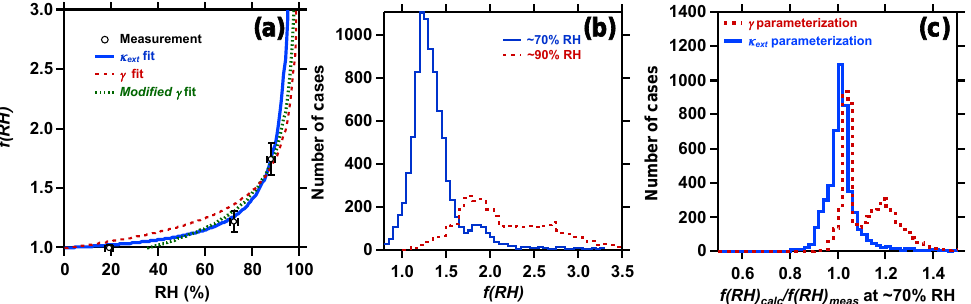
Figure 7. (a) Mean values of f (RH) determined profile data in the well-mixed and transition layers (below 2000m altitude) on 22 June 2013 over central Alabama from Fig. 3c (symbols), and curves from the γ power-law parameterization (dashed line, Eq. 1) and the κ ext parame- terization (solid line, Eq. 6) fitted to the three data points. The green dashed line shows a fit to the γ parameterization assuming RH 0 = 35% (see Sect. 3.4). Error bars show the propagated measurement uncertainties and measurement standard deviation. (b) Histograms of values of f (RH) measured at medium RH (70 ± 3%) and at high RH (86–94%) for all of the data selected for this study. (c) Ratio of calculated to measured f (RH) at ∼ 70% RH for the γ and κ ext parameterizations for all of the data selected for this